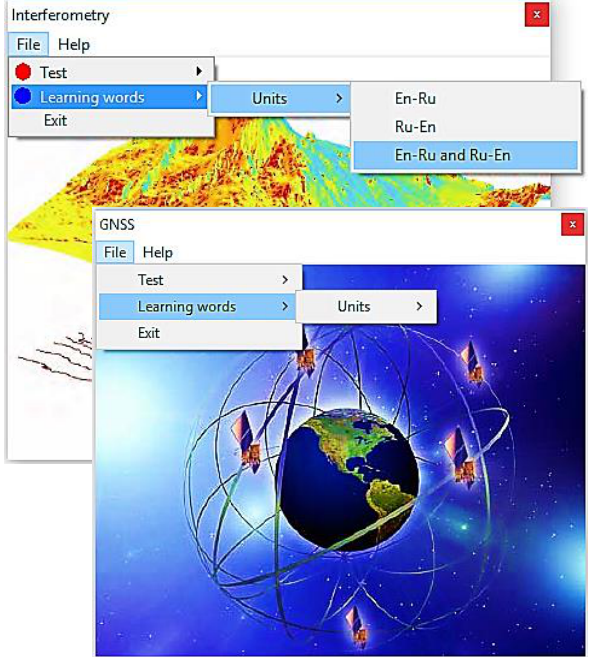
Figure 2. ESP software for learning, revision, and self-